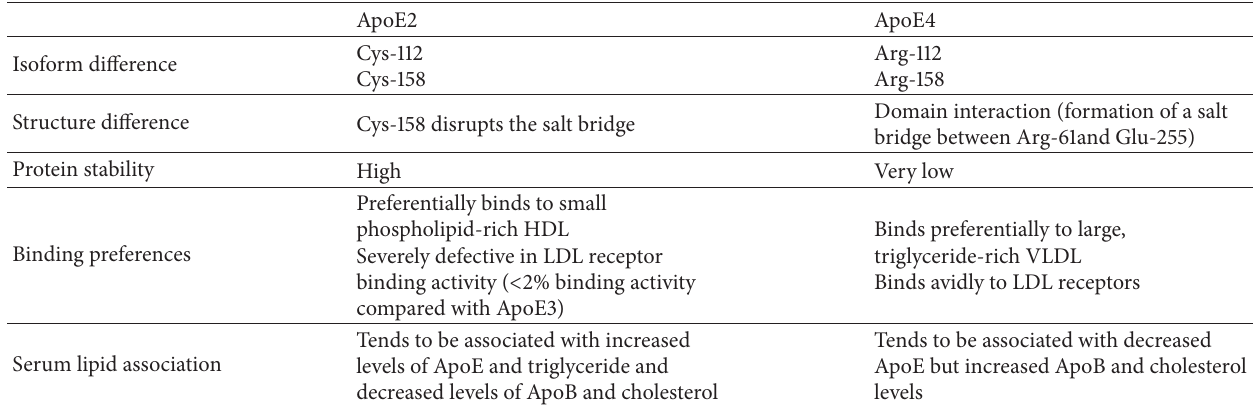
Table 1: Main differences between ApoE2 and ApoE4